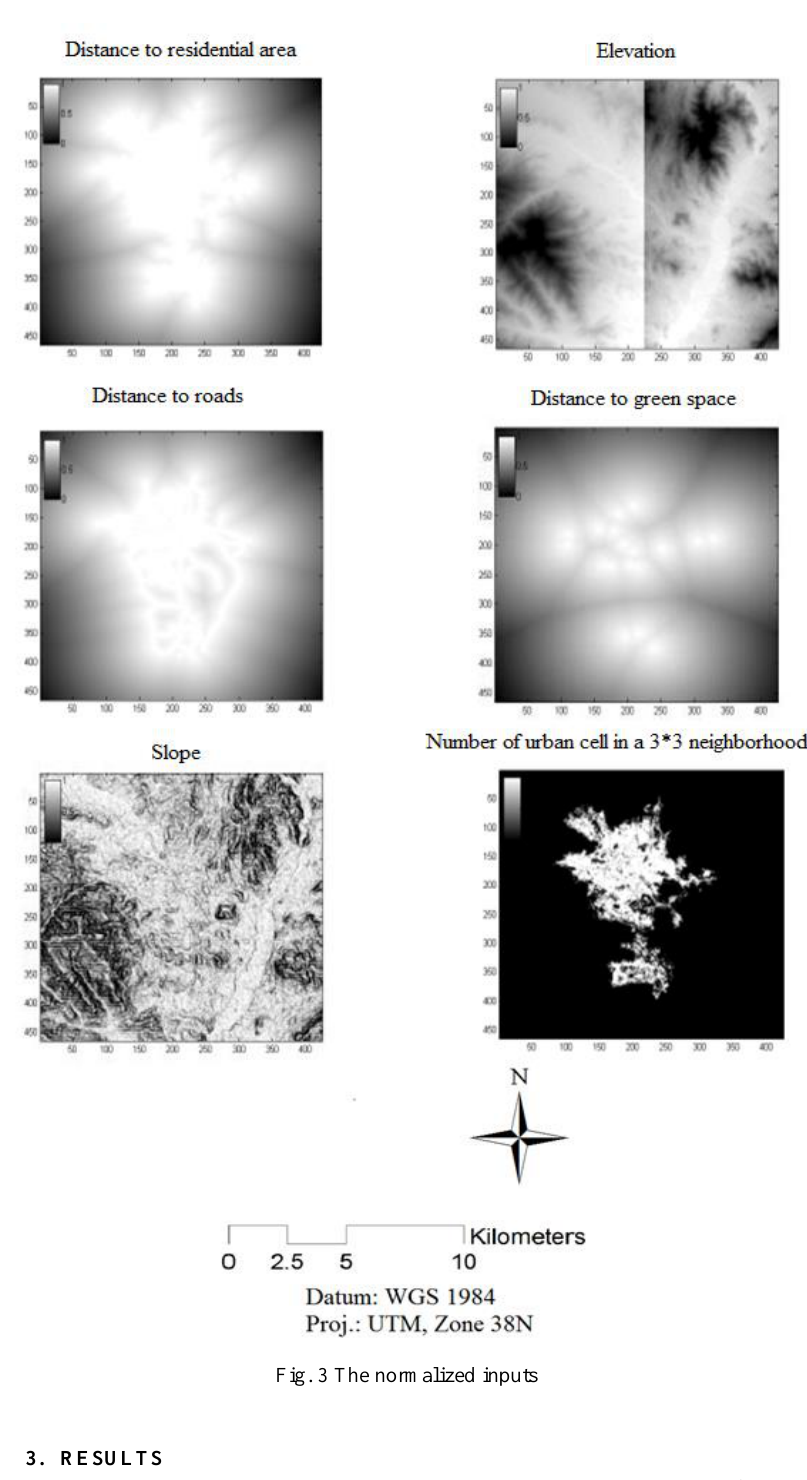
Fig. 3 The normalized